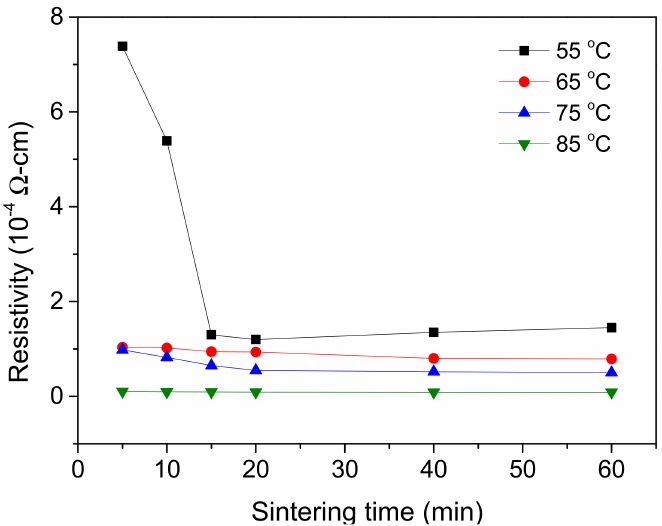
Figure 10. Effect of sintering temperature and time on electrical